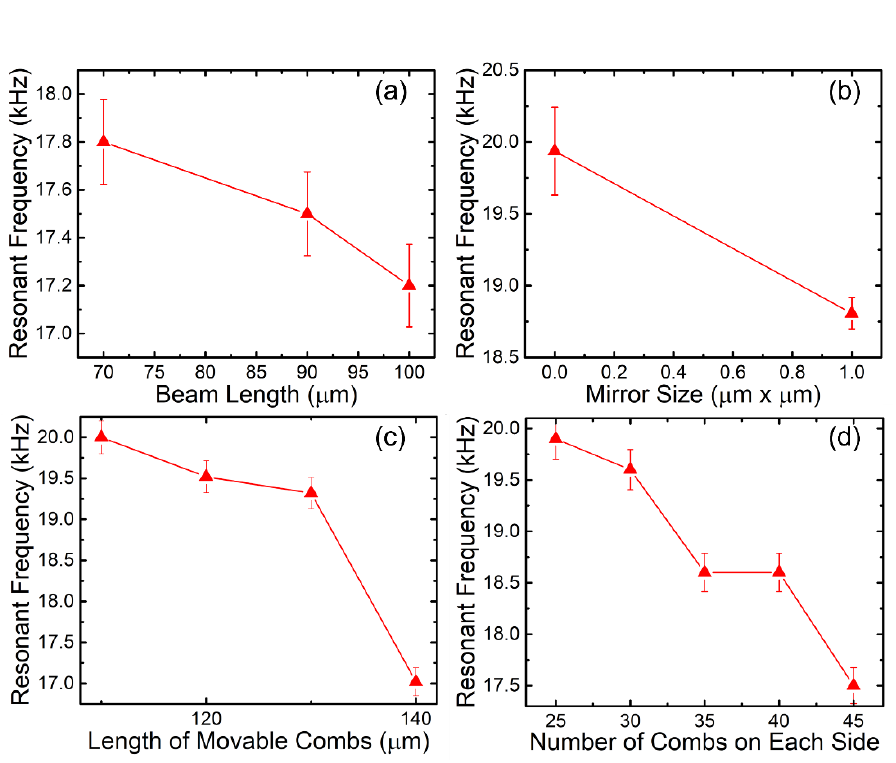
Figure 6. Resonant frequency as function of ( a ) beam length, ( b ) mirror size, ( c ) comb length and ( d ) the number of combs.